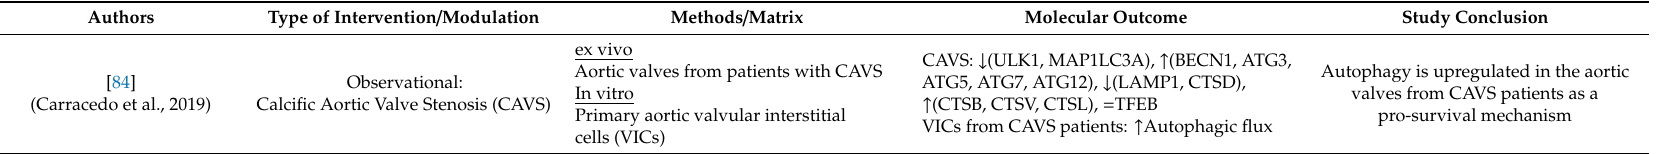
Table 2. Studies on autophagy in valvular